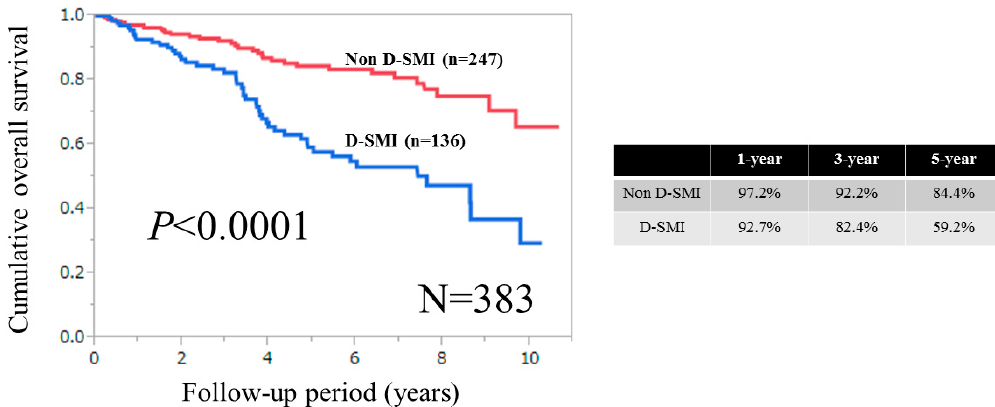
Figure 2. Cumulative overall survival for the entire cohort ( n = 383). The one-, three-, and five-year cumulative OS rates were 92.7%, 82.4% and 59.2%, respectively, in patients with decreased SMI (D-SMI), and 97.2%, 92.2% and 84.4%, respectively, in patients without D-SMI ( p < 0.0001). D-SMI was defined according to the Asian Working Group for Sarcopenia criteria. The cut-off values for SMI are 7.0 kg/m 2 for males and 5.7 kg/m 2 for females. SMI: skeletal muscle mass index; D-SMI: decreased SMI.